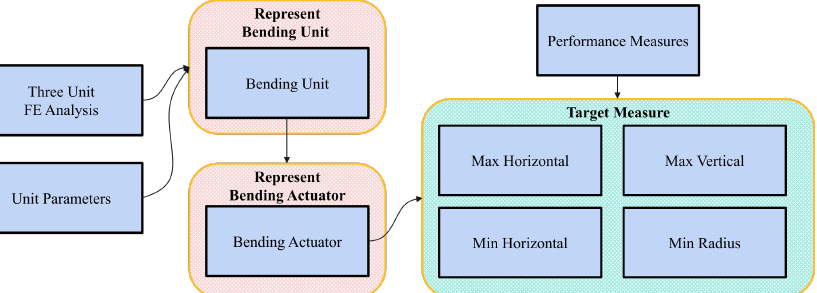
Figure 7. ESP framework for generating candidate designs for various pneumatic bending actuators to replicate the work of Ellis et al. [24].